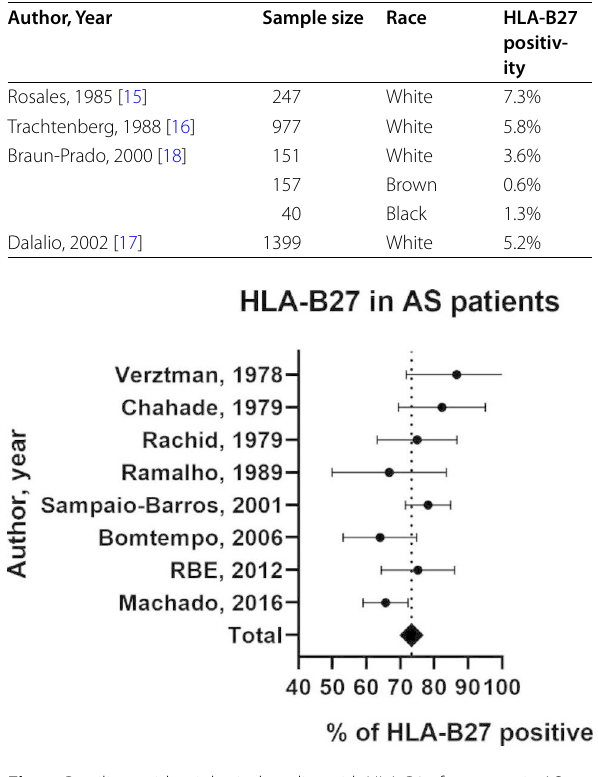
Fig. 1 Brazilian epidemiological studies with HLA-B27 frequency in AS pa- tients. Data were adapted from the published references